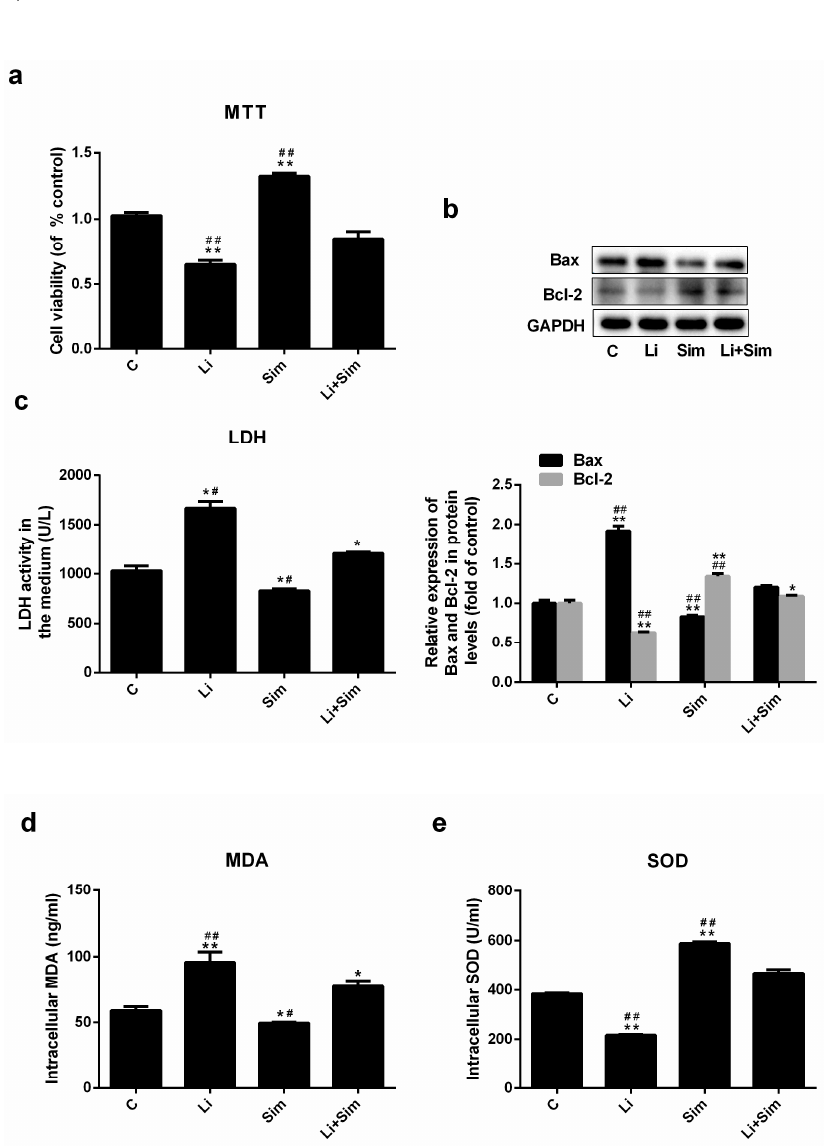
Figure 2. Simvastatin attenuates the dysfunction of endothelial cells under oxidative stress by inhibiting the Wnt / β -catenin pathway. ( a ) The viability of each group was measured by MTT assay ( b ) The protein levels of Bax and Bcl-2 ( c ) LDH level, ( d ) MDA content and ( e ) SOD activity were measured. * p < 0.05 or ** p < 0.001 versus C group; # p < 0.05 or ## p < 0.001 versus Li + Sim group, n = 3 or 6. C, HUVECs treated with H 2 O 2 ; Li, C group treated with LiCl; Sim, C group treated with simvastatin; Li + Sim, C group treated with simvastatin and LiCl.